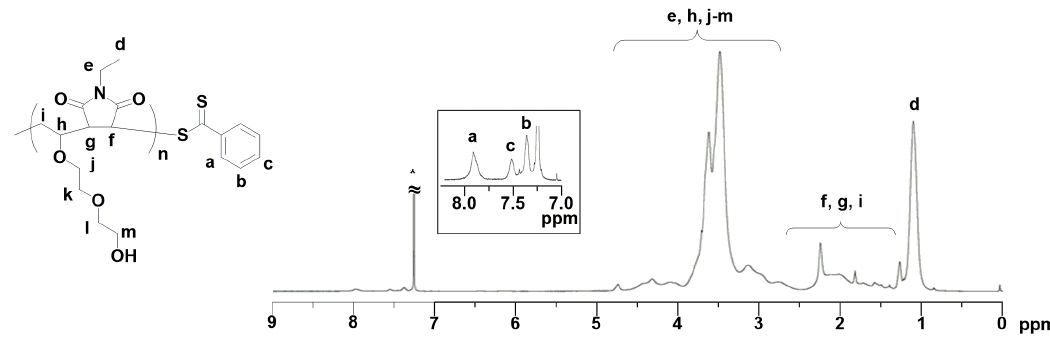
Figure 3. 1 H NMR spectrum of poly(DEGV- alt -EtMI) in CDCl 3 . Table 1. RAFT copolymerization of DEGV and EtMI 1 .